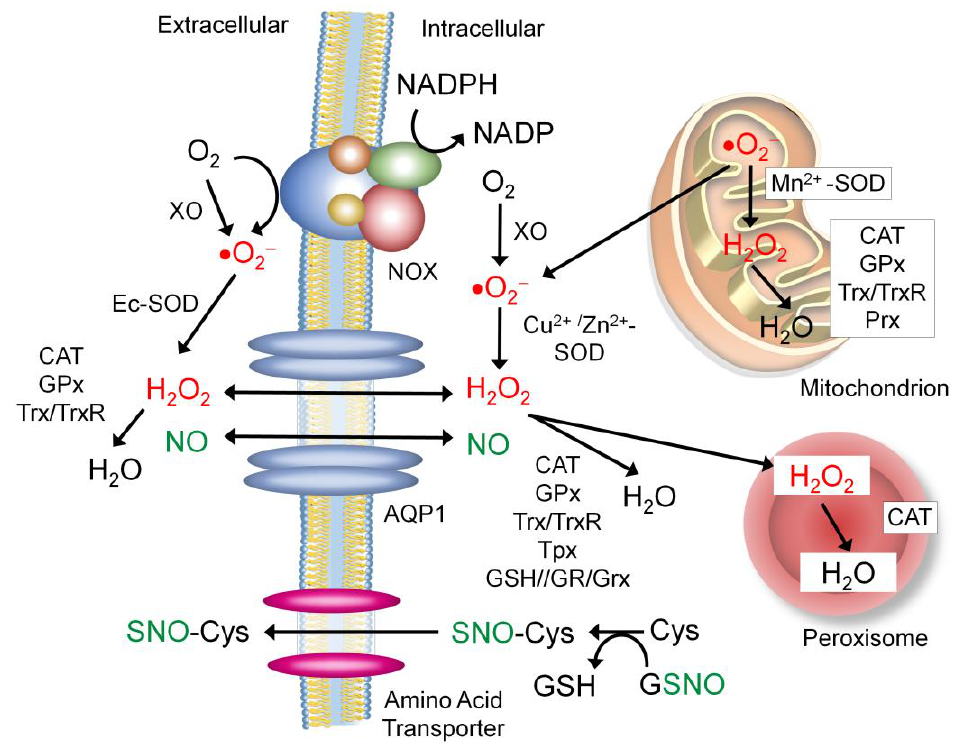
Figure 5. Tra ffi cking of the extracellular and intracellular ROS and NO. Abbreviations: CAT: catalase, Cu 2 + / Zn 2 + -SOD: copper / zinc superoxide dismutase, Ec-SOD: extracellular superoxide dismutase, SNO: S-nitrosocysteine, GPx: glutathione peroxidase, GSH: glutathione, GSNO: S-nitrothiolglutathione, GR: glutathione reductase, Grx: glutaredoxin, Mn 2 + -SOD: manganese superoxide dismutase, NOX: NADPH oxidase, Prx: peroxiredoxin, Trx: thioredoxin, TrxR: thioredoxin reductase, and XO: xanthine